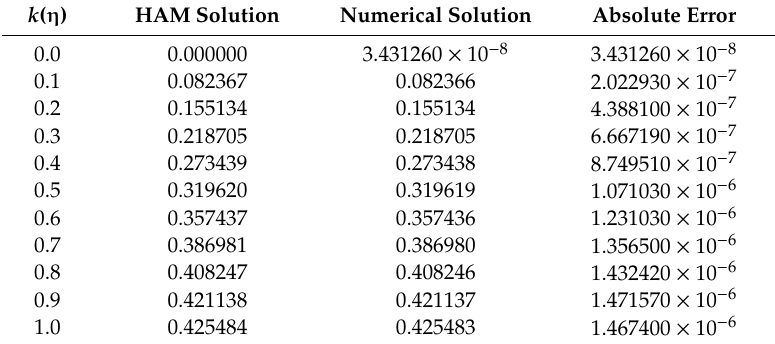
Table 2. Comparison of HAM and numerical solution for k ( η ).